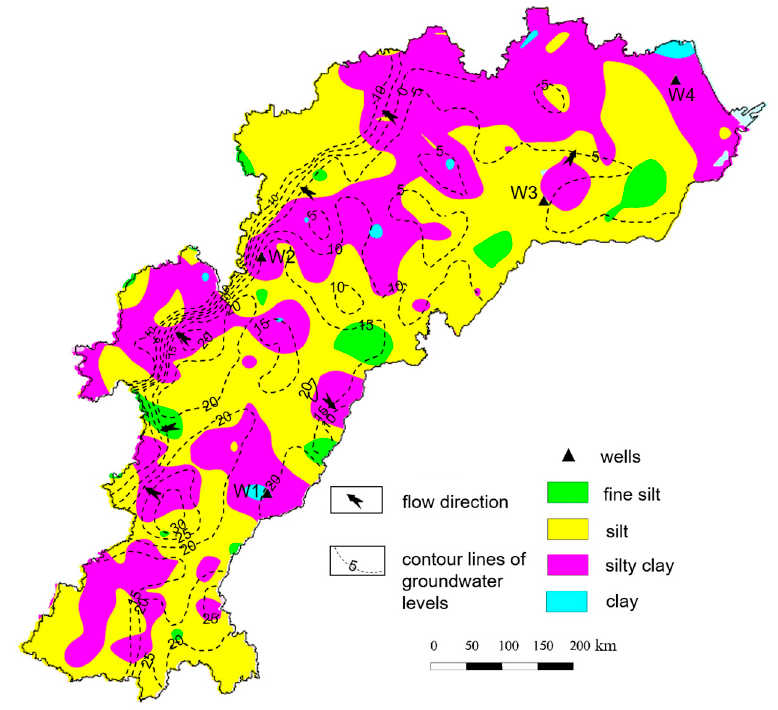
Figure 2. Vadose zone lithology and the flow direction map (2020).